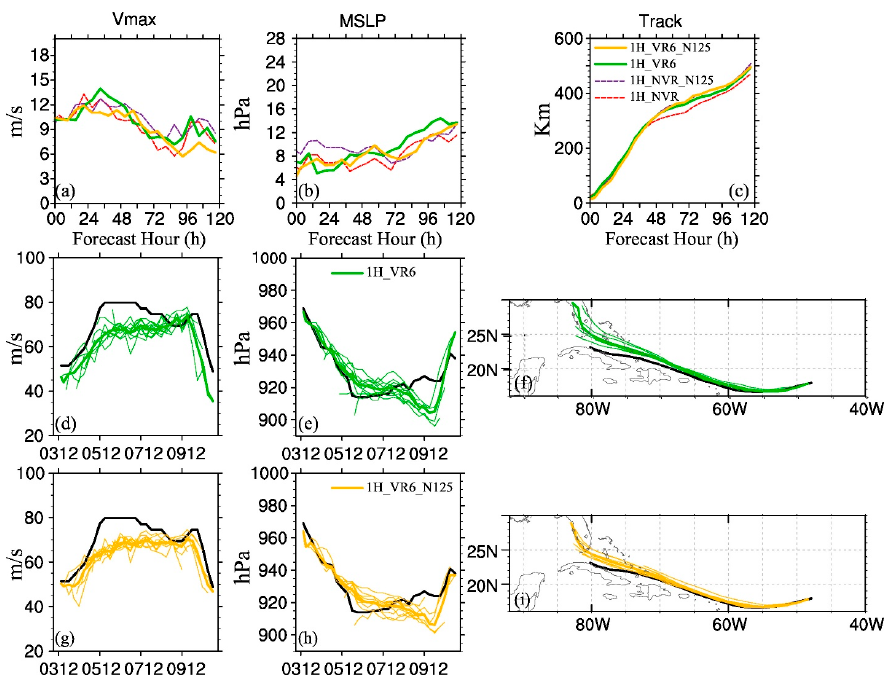
Figure 11. Same as Figure 2, except for “1H_VR6” (solid green), “1H_VR6_N125” (solid gold), “1H_NVR” (dashed red), and “1H_NVR_N125” (dashed purple). Remote Sens. 2022 , 14 , x FOR PEER REVIEW The intra-comparison between “1H_VR6” and “1H_VR6_N125” indicates that when VR exists, the inner-core AMVs from “1H_VR6” are slightly degrading the intensity pre- dictions as compared to “1H_VR6_N125”, especially for the long-term predictions after 72~80 h (Figure 11). This degradation from the assimilation of inner-core AMVs is con- flicting with the hourly 3DEnVar experiments without VR (“1H_NVR” vs. “1H_NVR_N125”; Figure 2). Figure 12 shows that “1H_VR6_N125” is capturing the dou- ble eyewall and secondary wind maximum at 8 km height better than the corresponding “1H_VR6” analysis. The negative impacts from the imbalanced thermal and dynamical fields from VR likely dominate the inner-core region when the location error is not a major issue in such an hourly configuration.